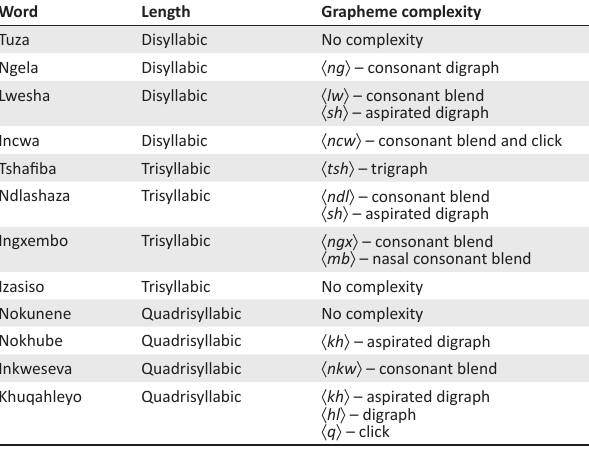
TABLE 2-A1: Pseudoword spelling